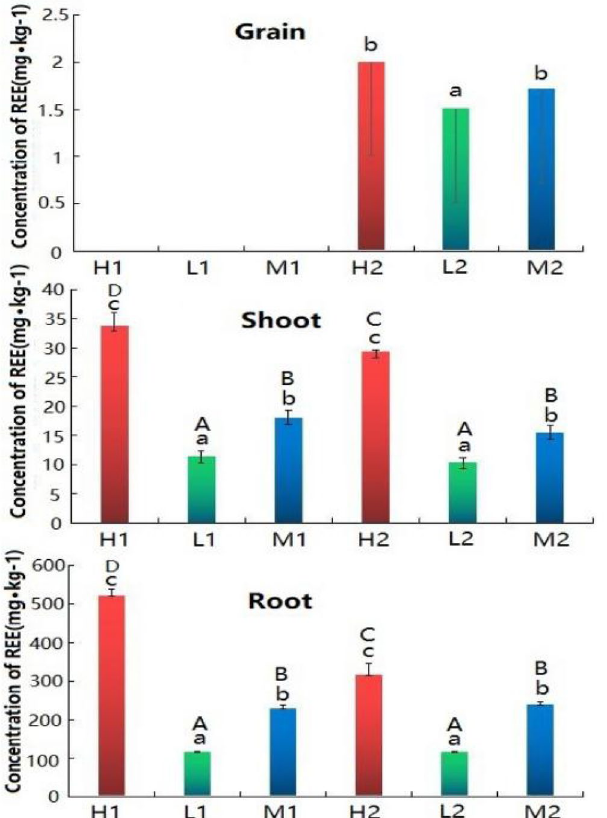
Figure 3. Content of rare earth elements in shoots and roots of rice at tillering stage and grains, shoots and roots at maturity stage. Different letters indicate significant differences between pot experiment rice in different soil (lowercase letters indicate significant differences in the same stage, capital letters indicate significant differences between the two stages), P <